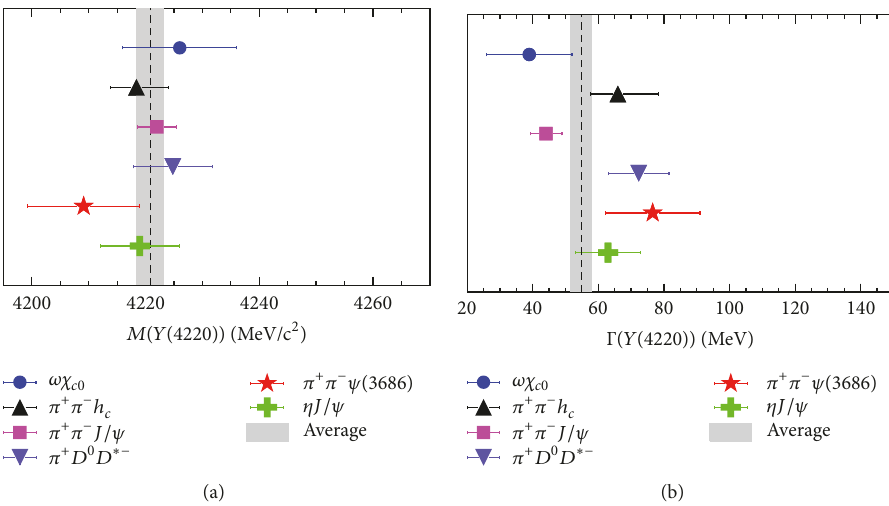
Figure 3: The fits to the mass (plot (a)) and width (plot (b)) of 𝑌(4220) from different decay modes. The grey hatched regions are the average values with uncertainty from fit